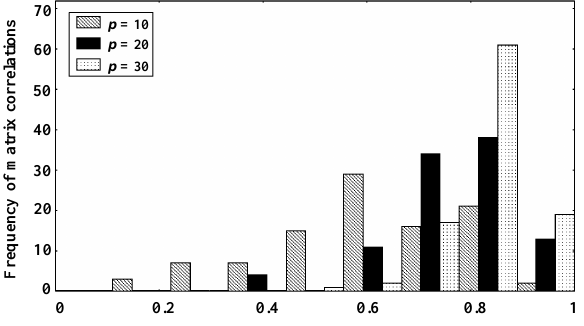
Figure 6 - Distribution of the matrix correlations (standardized Mantel tests) between Nei’s (1972) genetic and geographic distances among popu- lations. The genetic distances were calculated using increasing number of simulated p gene